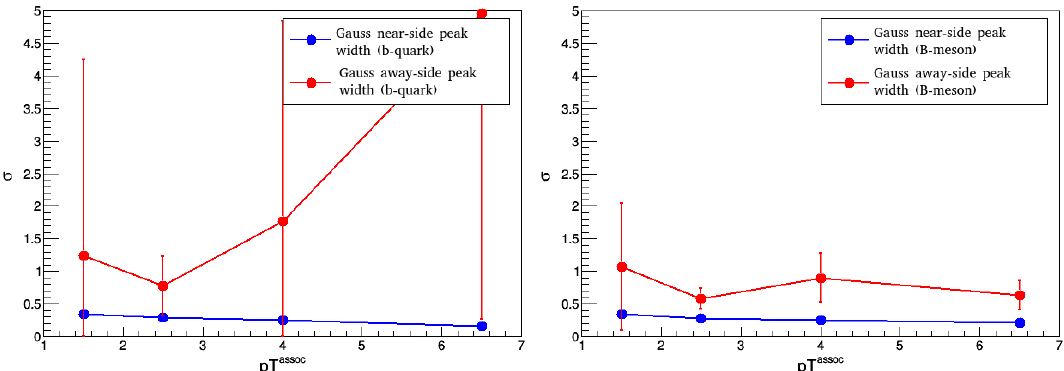
Figure 6. Comparsion of b quark (on the left ) and B meson (on the right ) correlations to